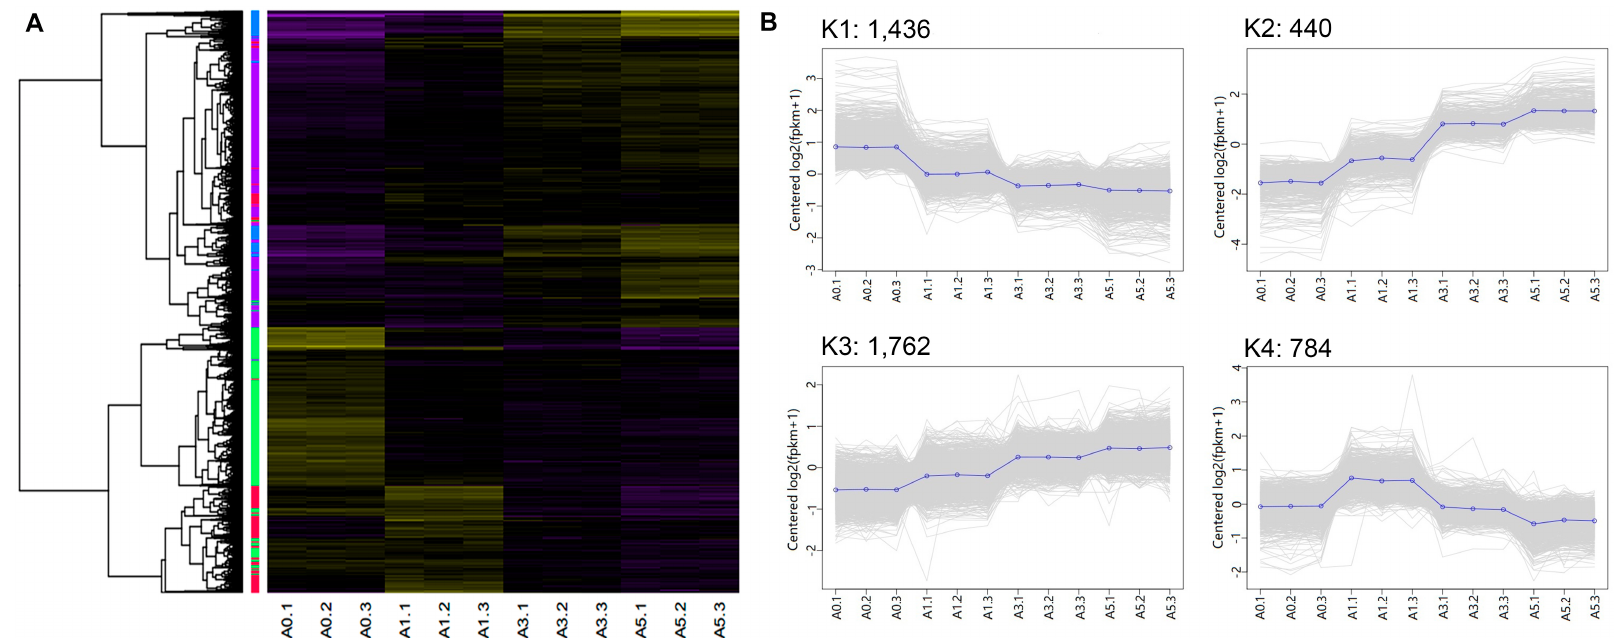
Figure 5. Hierarchical clustering of differentially-expressed genes (DEGs) (4422). ( A ) Heatmap plot of DEGs using the hierarchical clustering method; four cluster are shown; decreased ( purple ) and increased ( yellow ) expression of DEGs are distinguished from different stages; and ( B ) expression patterns of genes in the four clusters, namely K1–K4, corresponding to the hierarchical heatmap. The blue line represented the centered expression pattern of genes in each cluster.